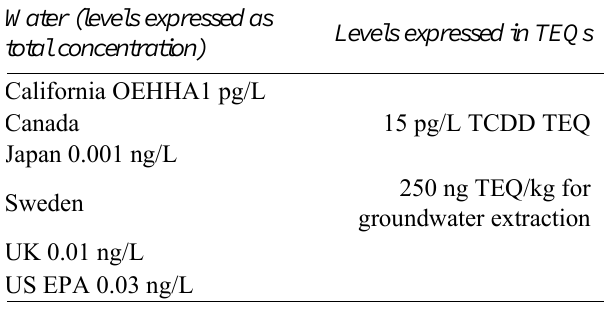
Table 1 Dioxin guideline values in water and acceptable human intakes limits by country Water (levels expressed